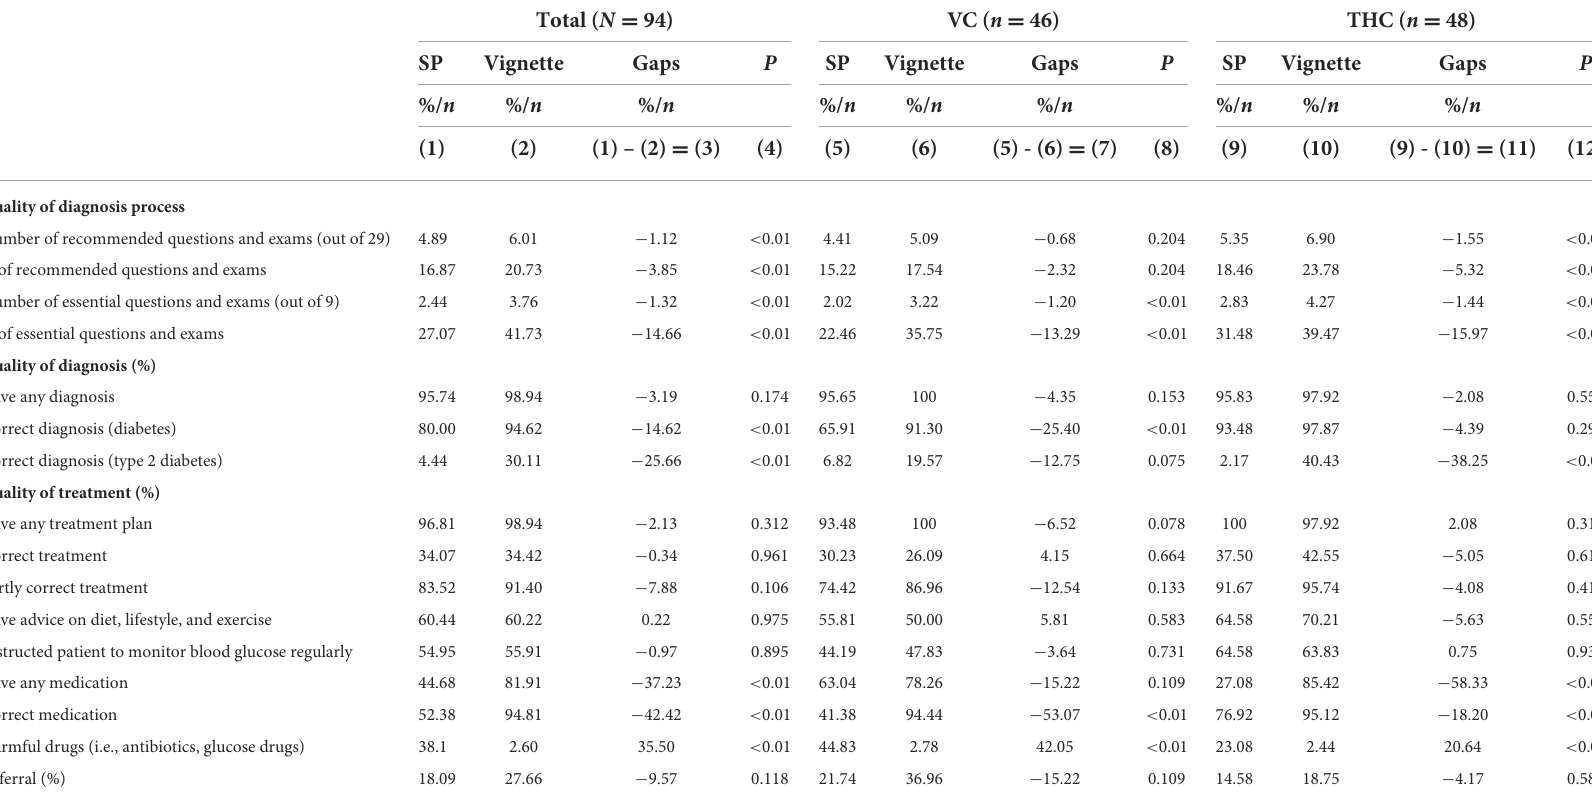
TABLE 6 The know-do gap of diagnostic questions asked and examinations performed, quality of diagnosis, and quality of treatment given for diabetes cases in Village Clinics (VCs) and Township Health Centers